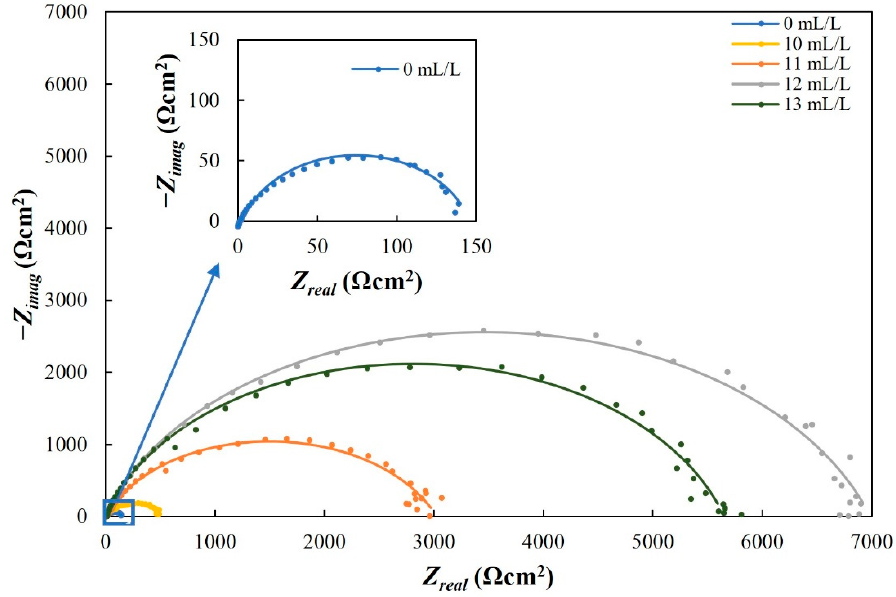
Figure 5. Nyquist plot scanned on the carbon-steel sample in the simulated brine saturated with CO 2 with and without the inhibitor in static conditions (Adapted from [24]).